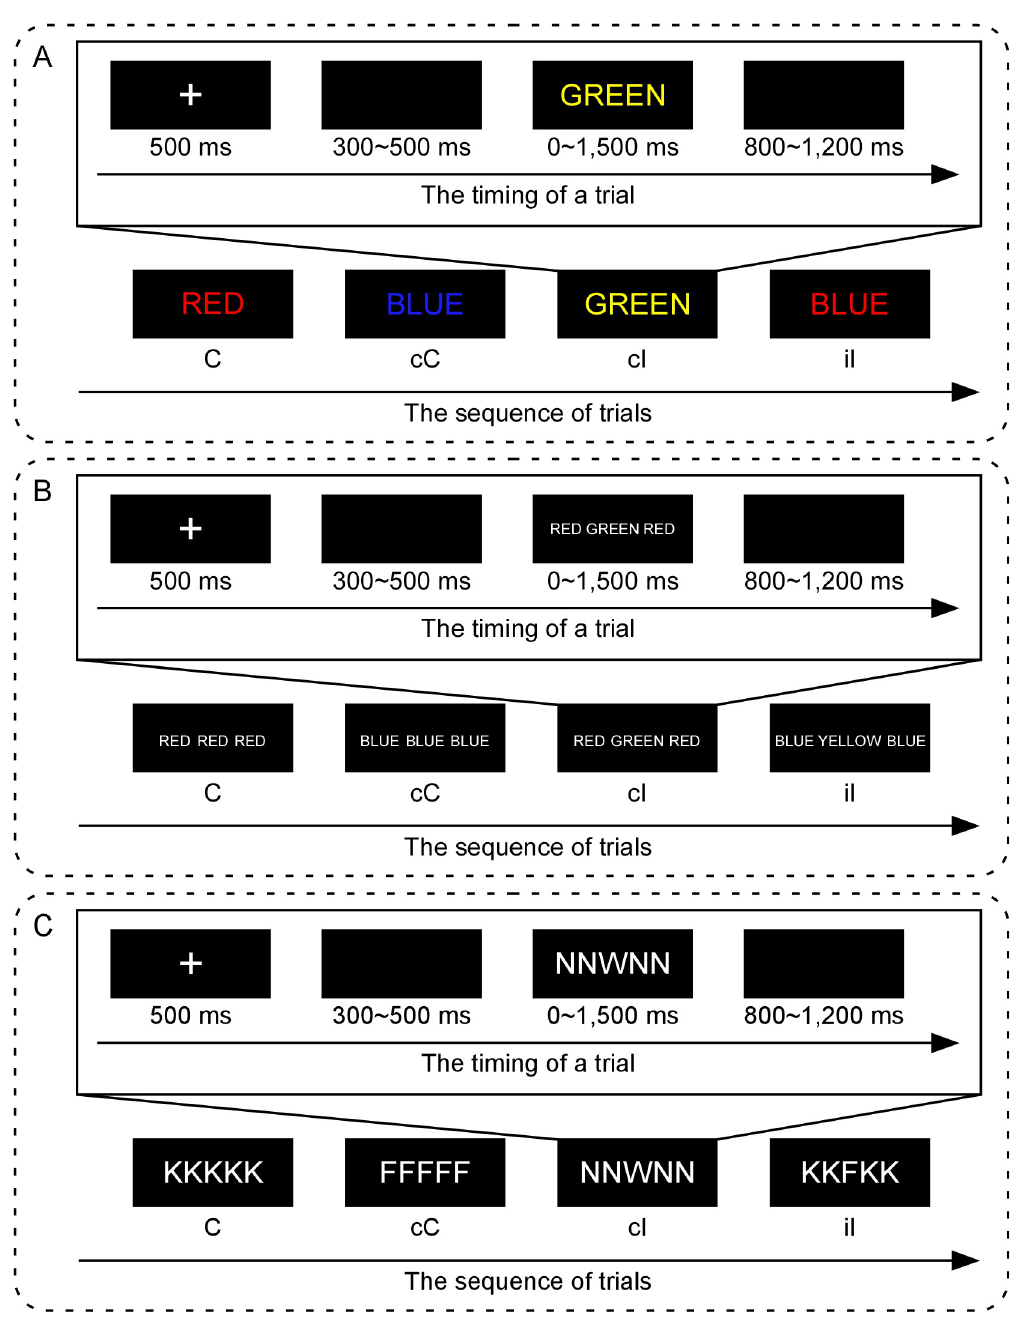
Fig 1. Experimental procedure for Experiments 1, 2, & 3. A probable pseudo-random sequence of four trials (bottom) and the detailed timing of one trial (top) are illustrated for Experiments 1, 2, & 3. Panel A shows the experimental procedure of the Stroop task in Experiment 1. Panel B shows the experimental procedure of the word Flanker task in Experiment 2. Panel C shows the experimental procedure of the letter Flanker task in Experiment 3. Note, in both Experiments 1 & 2, the words (“RED”, “GREEN”, “YELLOW”, and “BLUE”) are presented in Chinese with Song Ti font. and RT outliers ( ± 3 SDs, 0.76% of all trials) were excluded. The general linear model (GLM) was used to compare the mean RTs for each condition. The two-way repeated-measures analy- sis of variance (ANOVA) was conducted for the mean RTs with the following variables: the